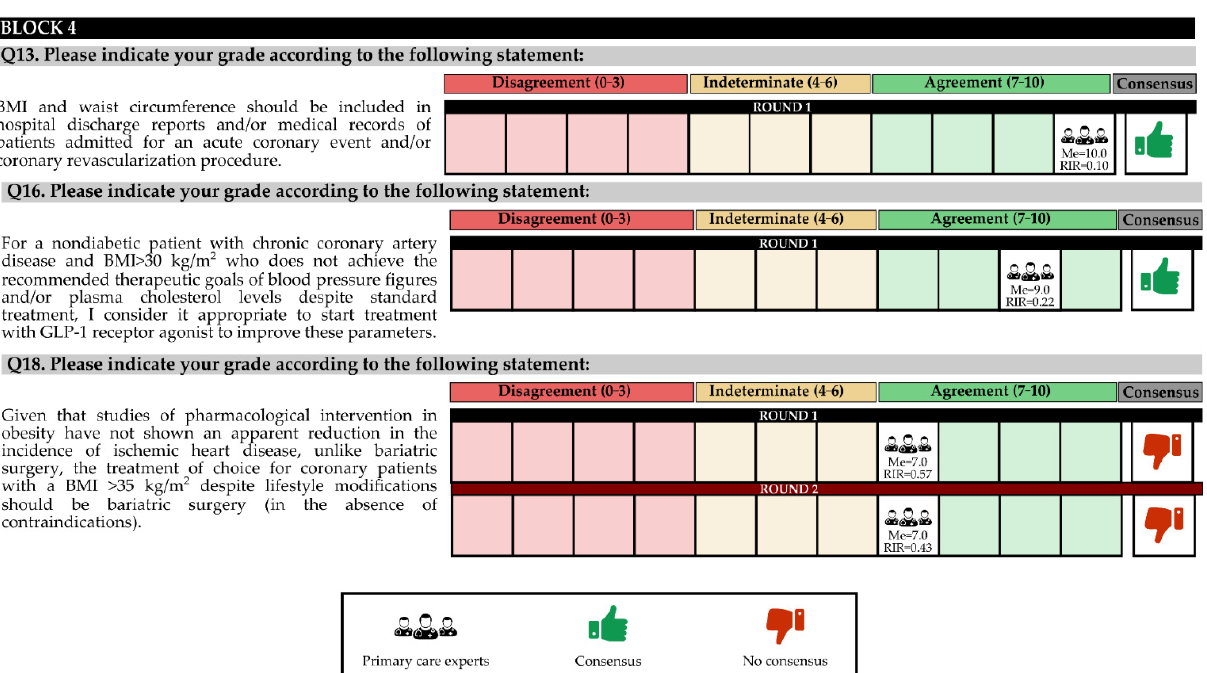
Figure 3. Discrete quantitative response questions of Block 2 under the Likert scale. IQR: Interquar- tile range; Me: Median.